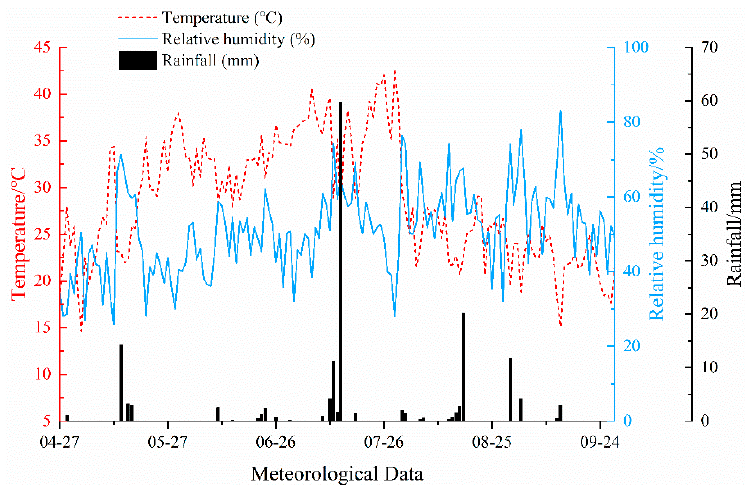
Figure 1. Meteorological data of the experimental site.